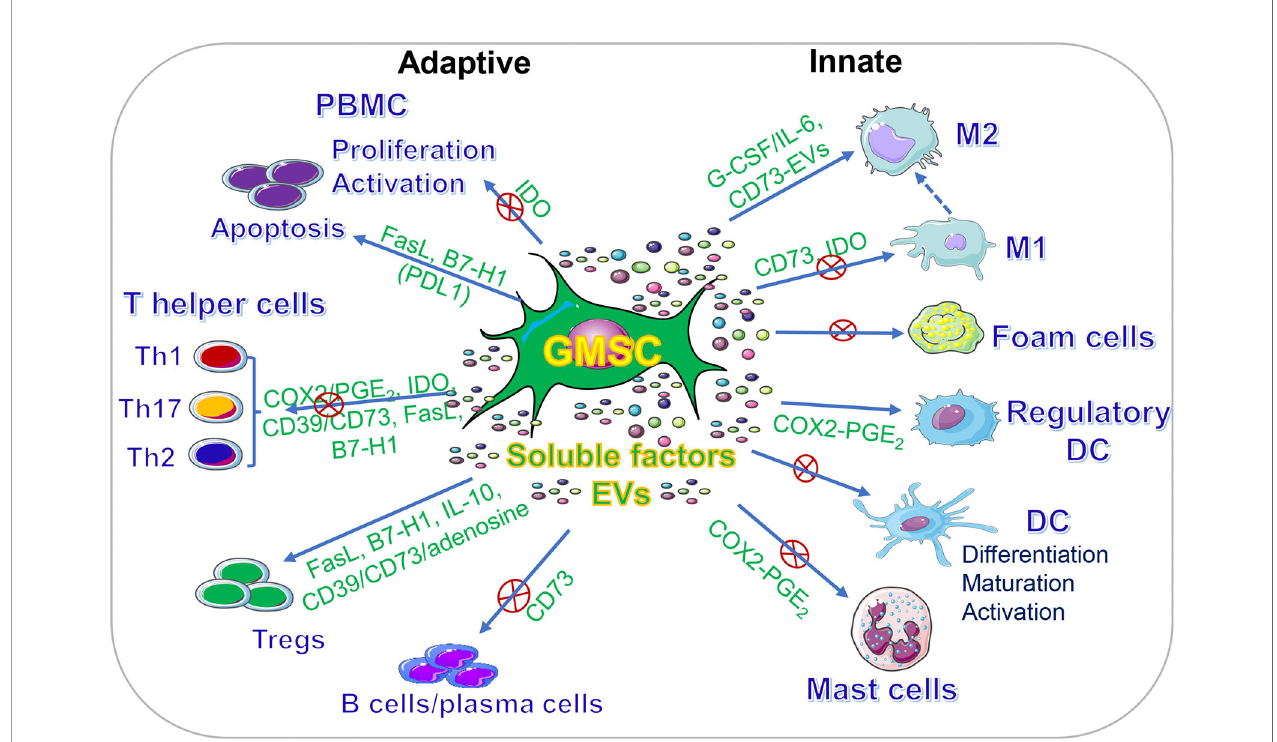
FIGURE 2 | Immunomodulatory effects of GMSCs on both innate and adaptive immune cells. PBMC, peripheral blood mononuclear cells; M2, M2 macrophages; M1, M1 macrophages; DC, dendritic cells; IDO, indoleamine 2,3-dioxygenase; COX2, cyclooxygenase-2; PGE2, prostaglandin 2; FasL, Fas ligand; EVs, extracellular vesicles; IL-10, interleukin-10; IL-6, interleukin-6. “ ⊕ ” means blocking or inhibiting. Portions of this fi gure were made using templates from SMART SERVIER MEDICAL ART